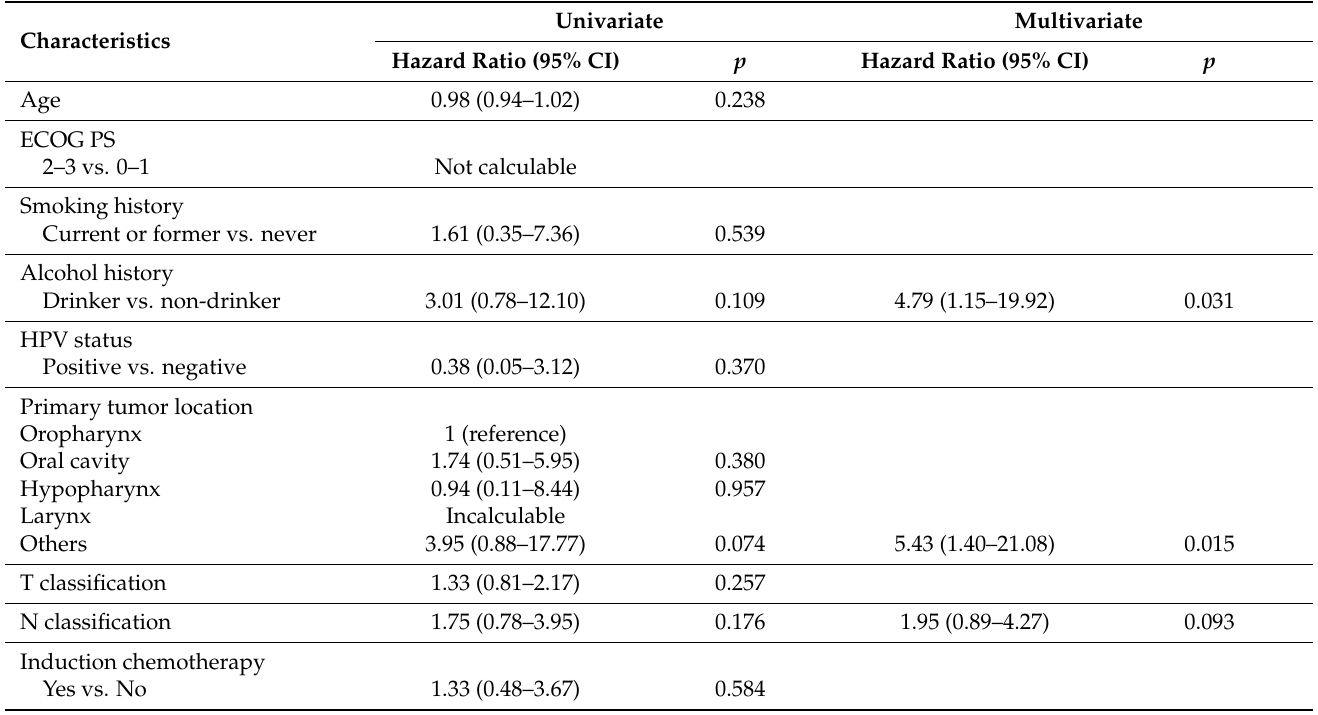
Figure 2. ( A ) Overall survival by treatment strategy in the female participants (n = 60). ( B ) Overall survival by treatment strategy in the propensity-score-matched male participants (n = 60). The multivariate analyses for mortality showed that drinking and other primary sites were two significant predictors for poor survival in the female patients with LA-HNSCC (Table 4). Table 4. Univariate and multivariate analyses for risk factors of overall survival in 60 female pa- tients.